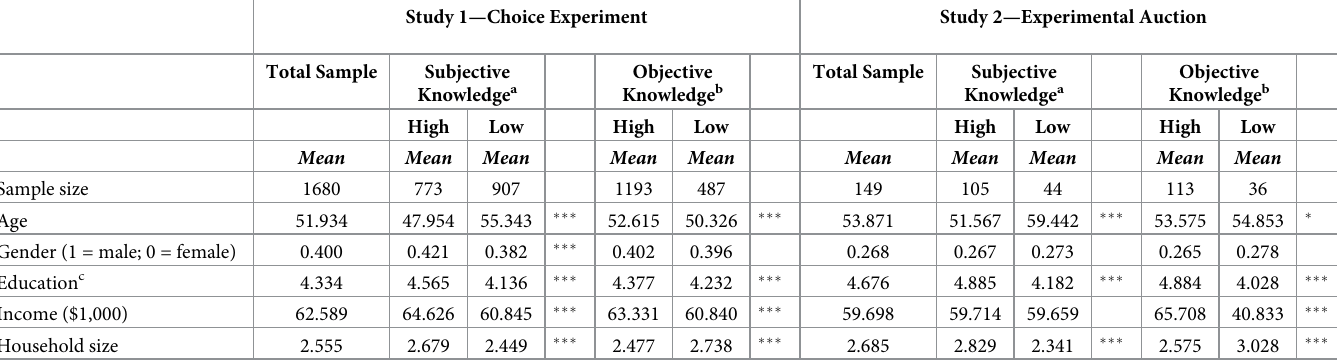
Table 2. Respondent socio-demographic summary statistics, by study and knowledge